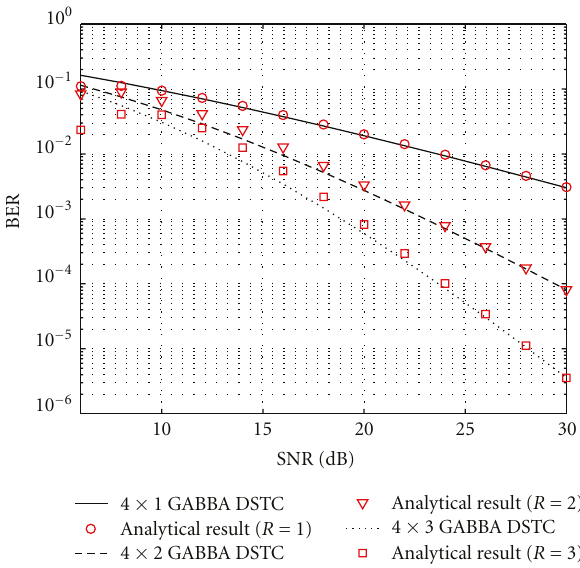
Figure 5: The average BER curves versus SNR of relay networks employing distributed space-time codes with BPSK